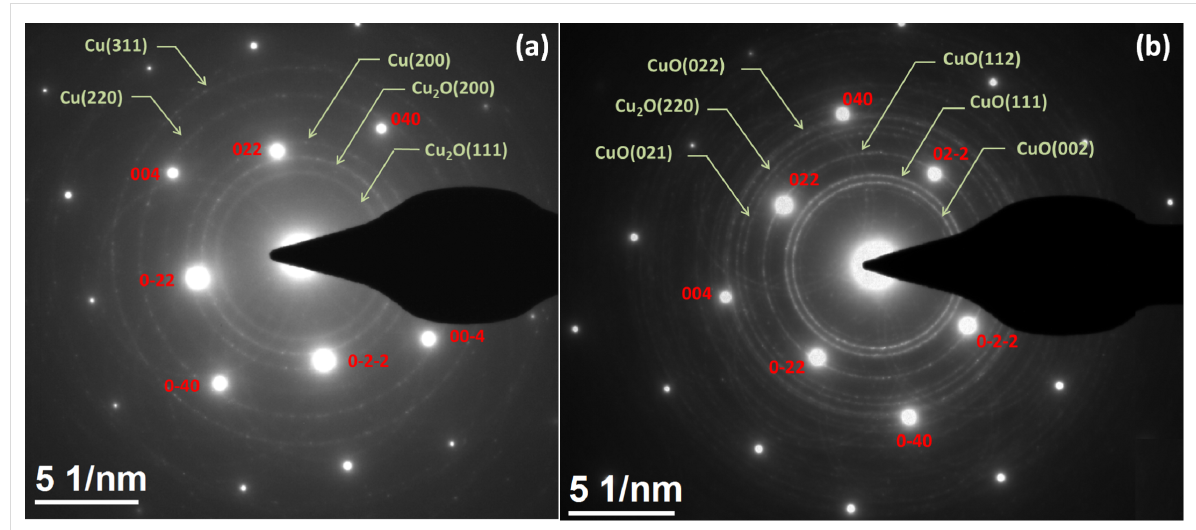
Figure 2: SAED pattern of (a) as-deposited copper nanoparticles on the silicon substrate (b) the same sample annealed at 500 °C in oxygen ambient. The bright spot (indexed in red) are from single crystal silicon and the ring patterns (indexed in green) are from polycrystalline Cu, Cu 2 O or CuO.